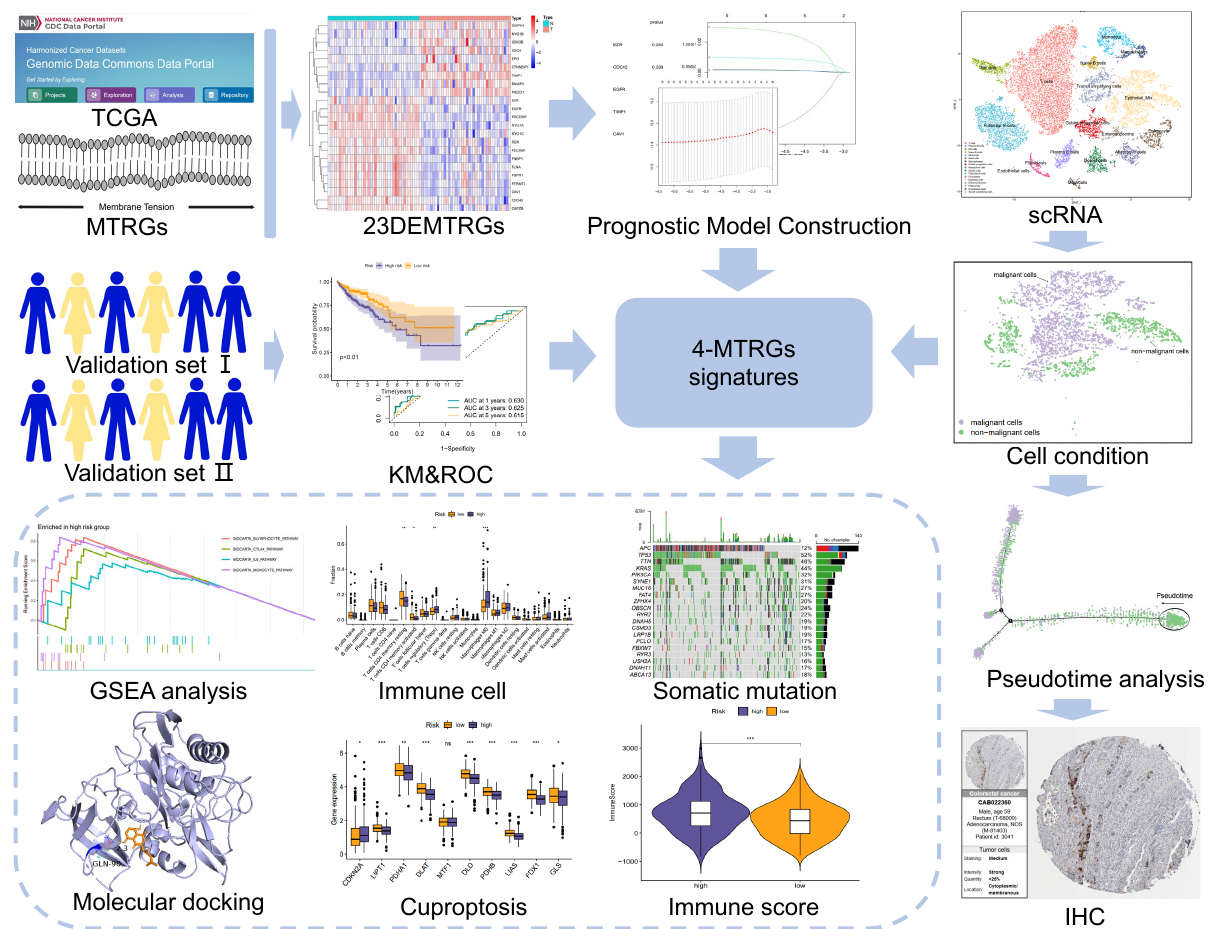
Figure 1. Flowchart of this study. * p < 0.05, ** p < 0.01, *** p <